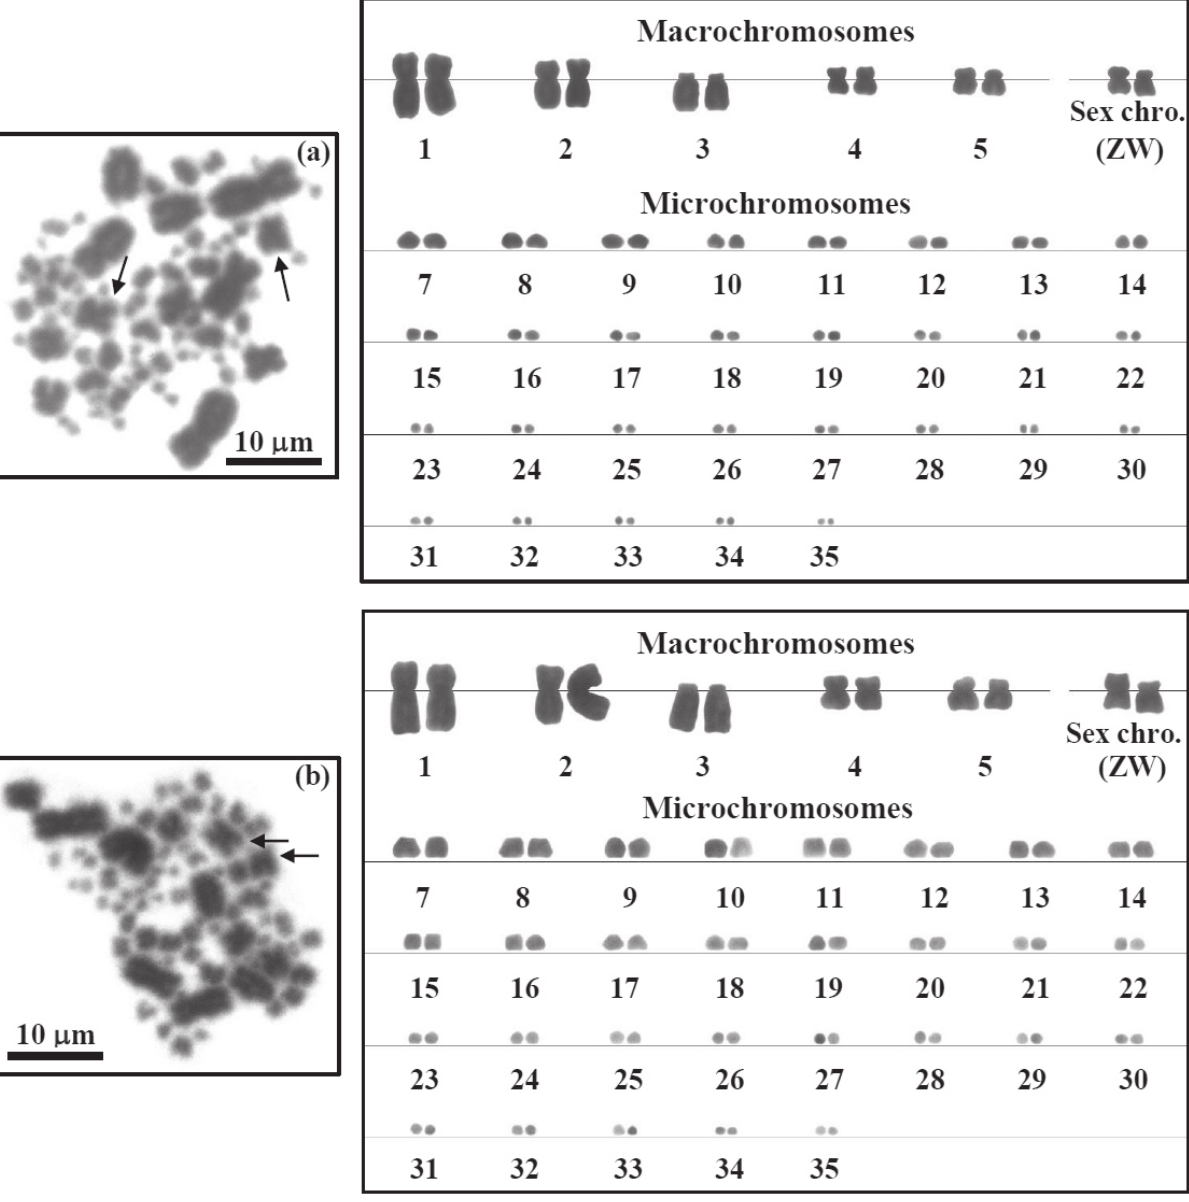
Figure 2. Metaphase chromosome plates and standardized karyotypes of embryonic individual 1 (a) and embryonic individual 2 (b) Spilope- lia chinensis , 2 n =70 by conventional